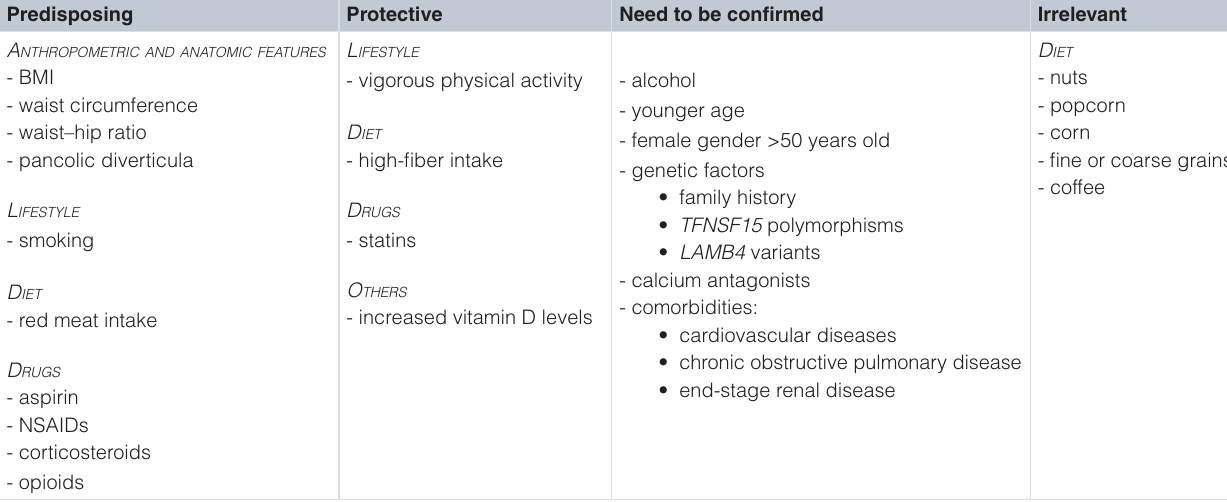
Table 1. Summary of predisposing and protective factors associated with primary and secondary prevention of acute